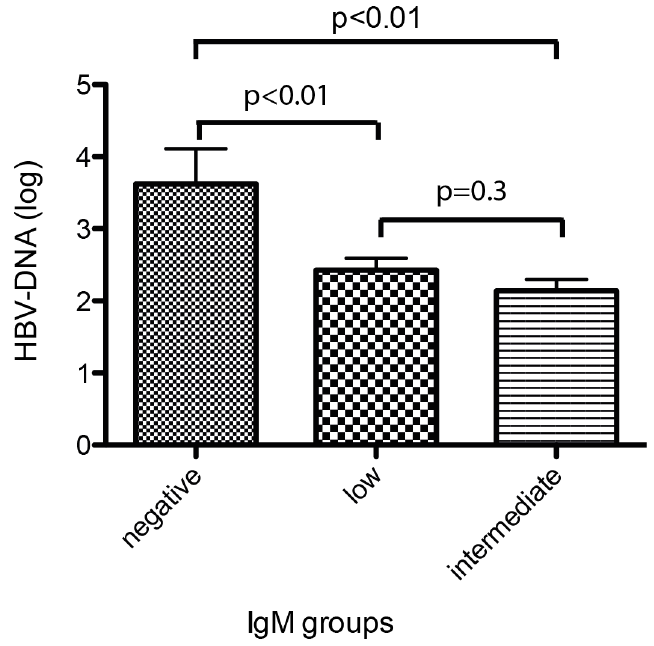
Figure 6. Distribution of HBV values according to Anti-HDV IgM categories in the HIDIT-2 cohort. HBV-DNA (log) is clearly associated with anti-HDV IgM indicated by ANOVA (p , 0.01) and by T-test during the different IgM groups.